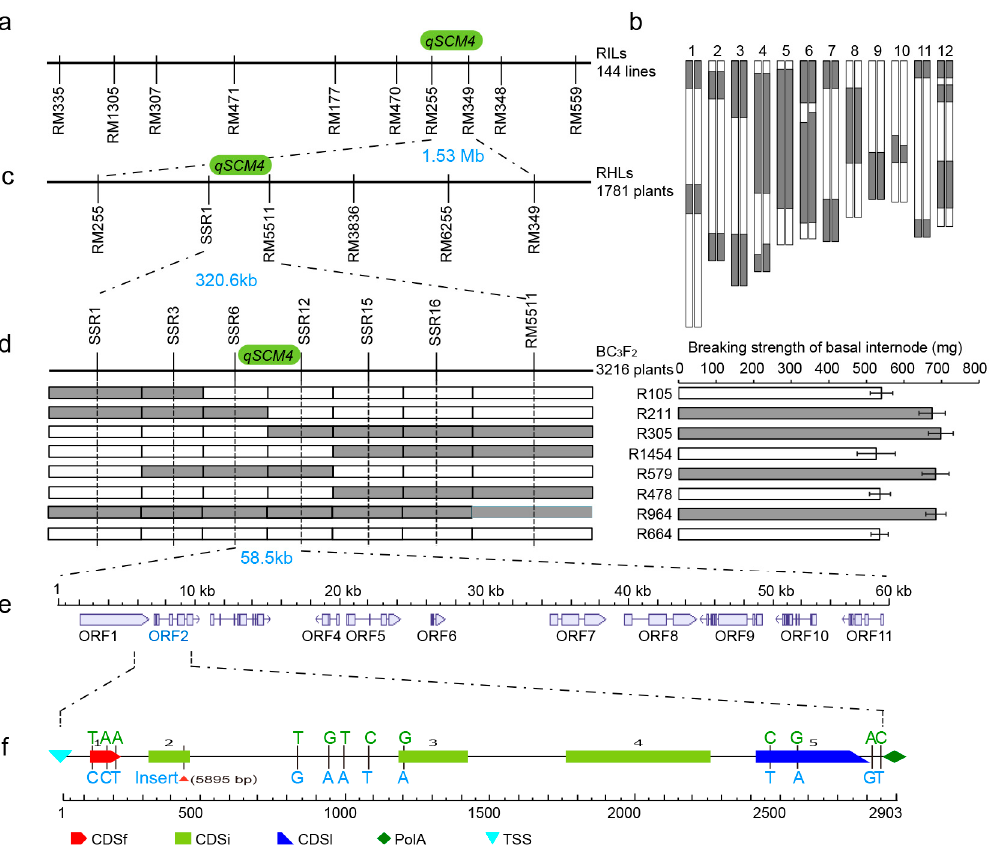
Figure 2. Fine mapping and candidate gene analysis of the strong culm and lodging resistance QTL qSCM4 : ( a ) genetic localization of qSCM4 in recombinant inbred lines population; ( b ) the genotypes of residual heterozygous line 08-3-2-1, The grey parts indicate the genotypes of the LTH, and the white indicate the genotypes of SH265; ( c ) fine mapping of qSCM4 in remaining heterozygous-derived populations; ( d ) fine mapping of qSCM4 in BC 3 F 2 segregating populations, The grey parts indicate the genotypes of the LTH, and the white indicate the genotypes of SH265; ( e ) candidate gene prediction for qSCM4 region; and ( f ) candidate gene DNA sequence variation of qSCM4